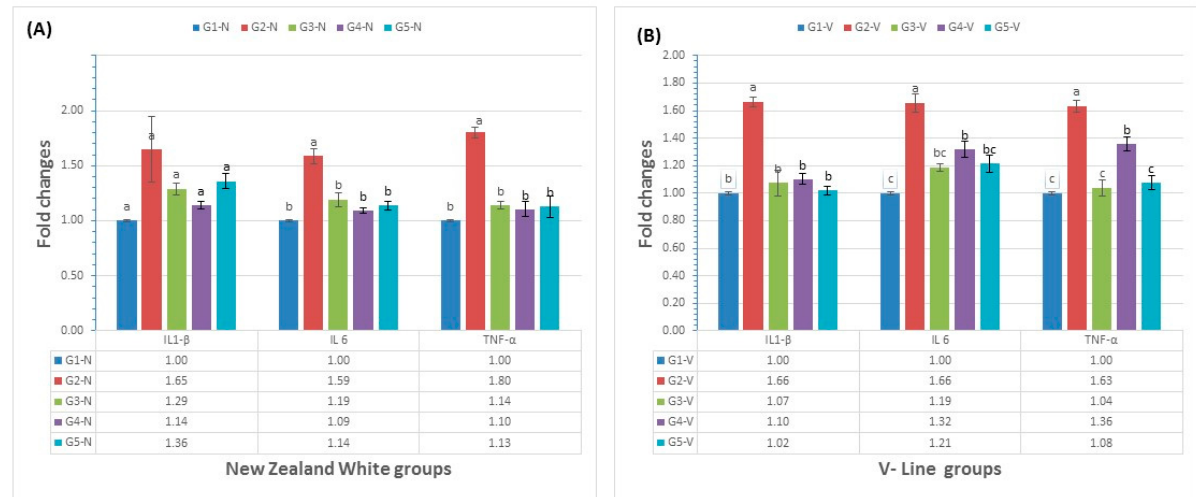
Figure 3. IL-1 β , IL6, and TNF- α changes in NZ and VL rabbits in response to coccidial infection and herbal extract treatment. Data are presented as mean ± standard error of the mean. G1-N, negative control group of New Zealand rabbits; G2-N, positive control group of New Zealand rabbits; G3-N, neem leaf extract treatment of New Zealand rabbits; G4-N, pomegranate peel extract treatment of New Zealand rabbits; G5-N, combined treatment of New Zealand rabbits; G1-V, negative control group of V-line rabbits; G2-V, positive control group of V-line rabbits; G3-V, neem leaf extract treatment of V-line rabbits; G4-V, pomegranate peel extract treatment of V-line rabbits; G5-V, combined treatment of V-line rabbit. Data obtained from 3 rabbits/group. ( A ) New Zealand White groups. ( B ) V-Line groups. Means that have no superscript in common are significantly different from each